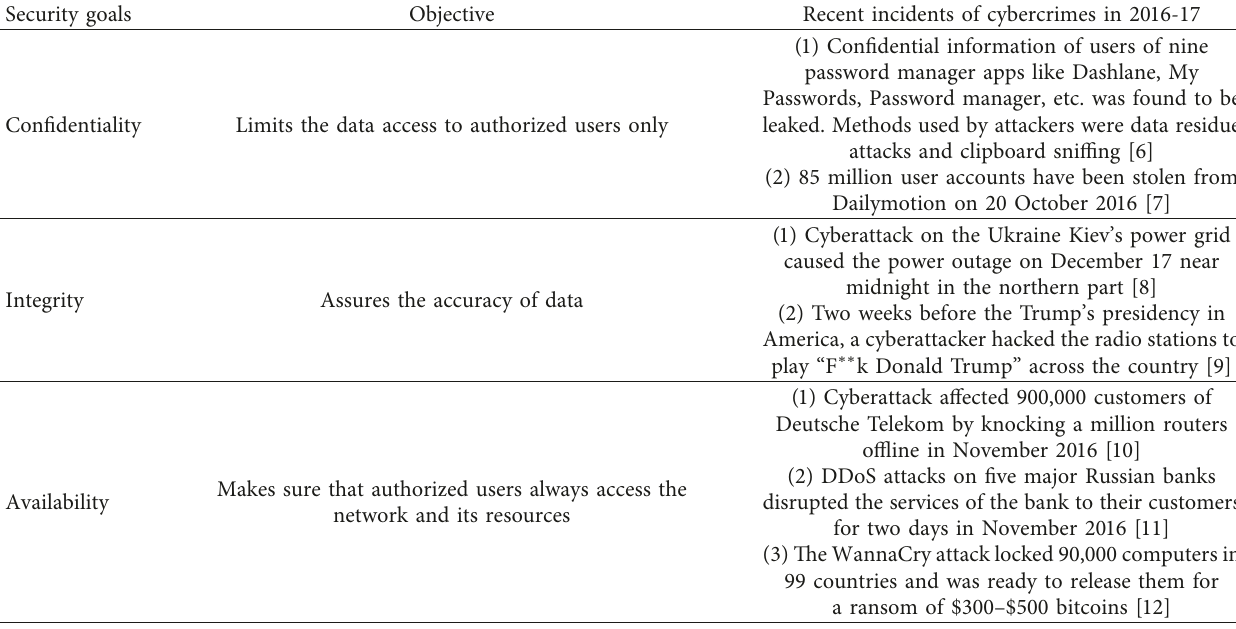
Table 1: Classification of recent cybercrimes on the basis of security fundamental principles. Security